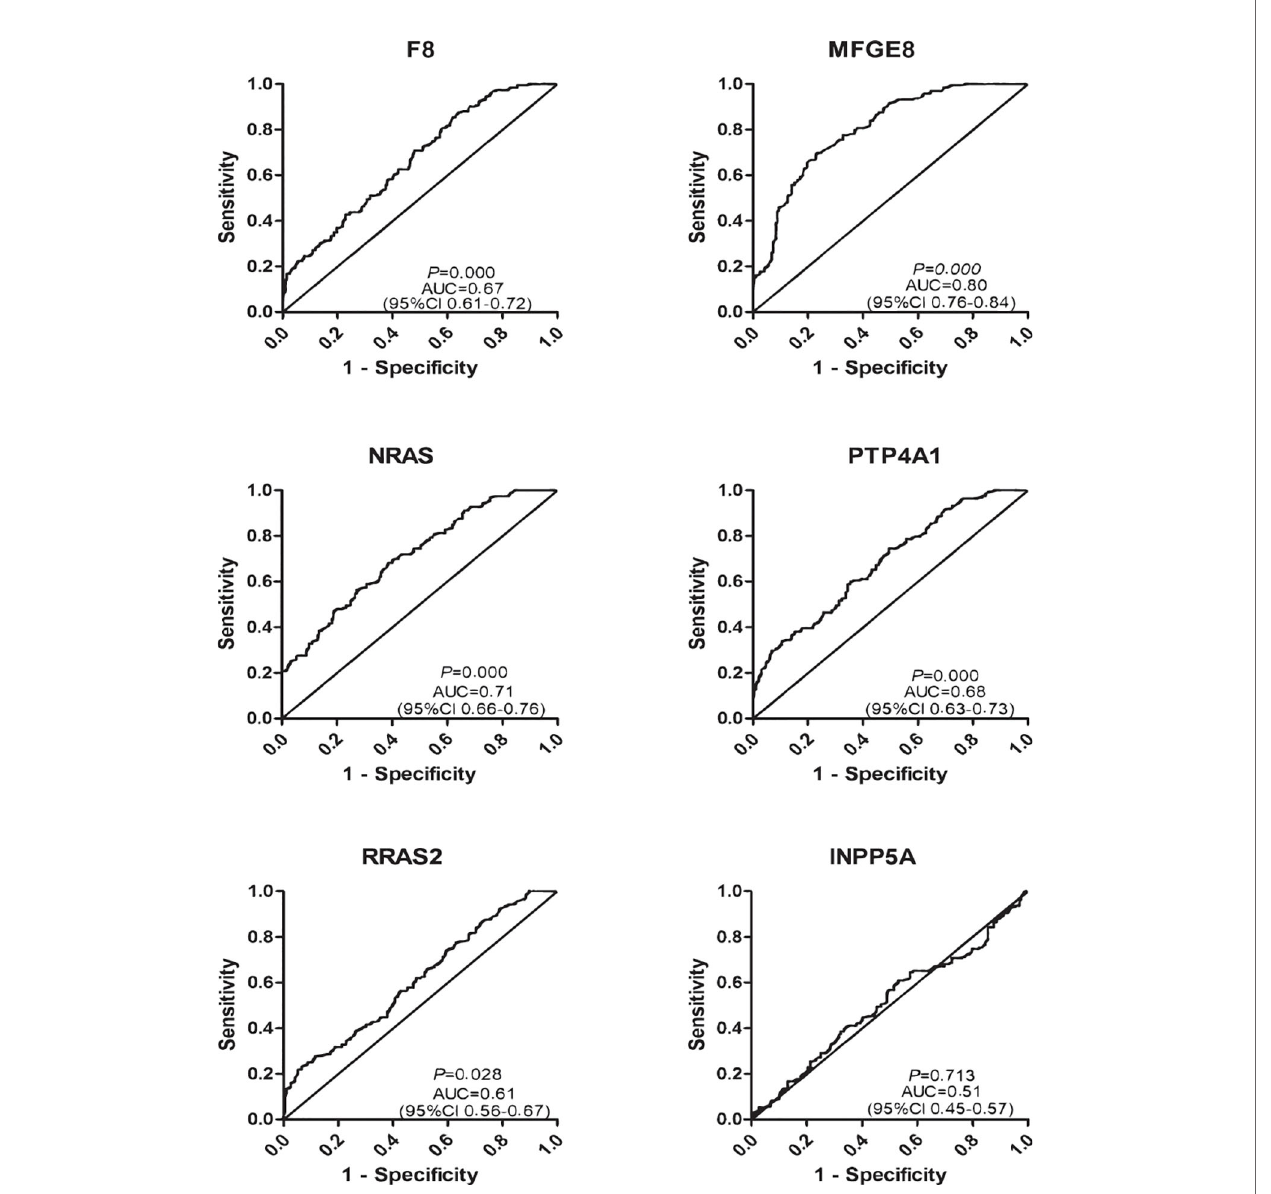
FIGURE 4 | Diagnostic performance of six anti-TAAs in the validation cohort for gastric cancer (GC)